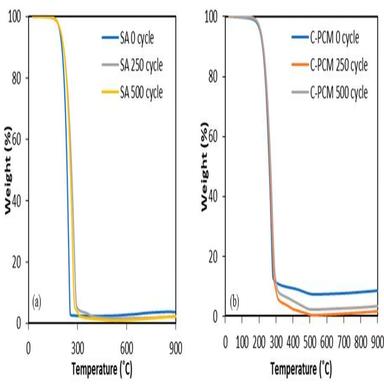
TGA analysis of samples after thermal cycling measurement of a) stearic acid and b) 15 wt% Al/SA C-PCM.